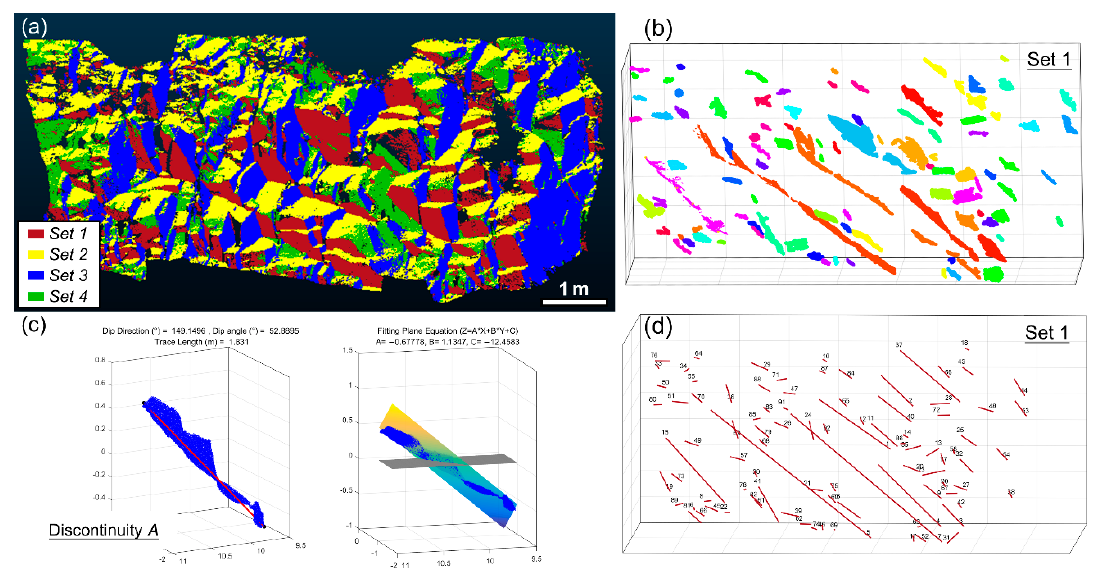
Figure 6. ( a ) Discontinuity set assignment to each point of Site 1 using different colors. ( b ) Each individual discontinuity of Set 1 is separated and delineated using different colors. ( c ) One example of parameters calculated for discontinuity A : orientation, trace length, and fitting plane equation. ( d ) Digital trace mapping of Set 1.